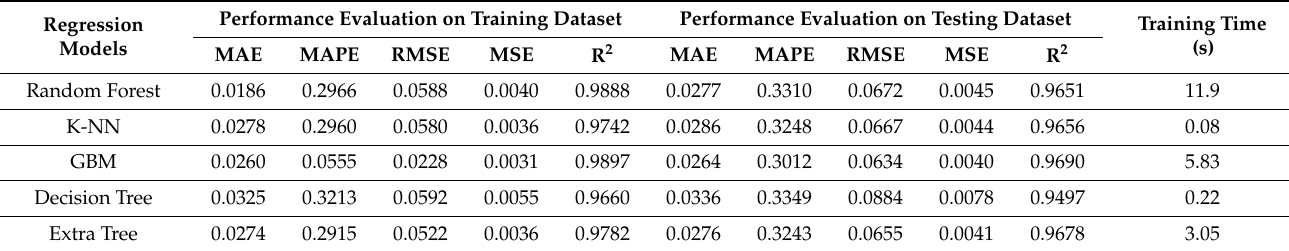
Table 3. Model performances based on the MAE, MAPE, RMSE, MSE, and R 2 metrics. Italic and bold sections indicate better performance. Regression